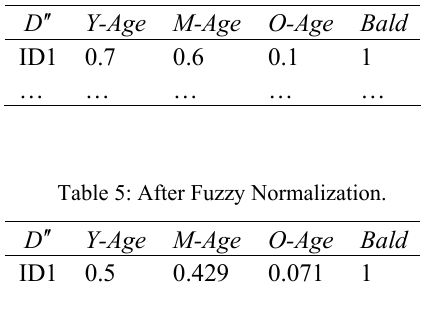
Table 4: Without Fuzzy Normalization.